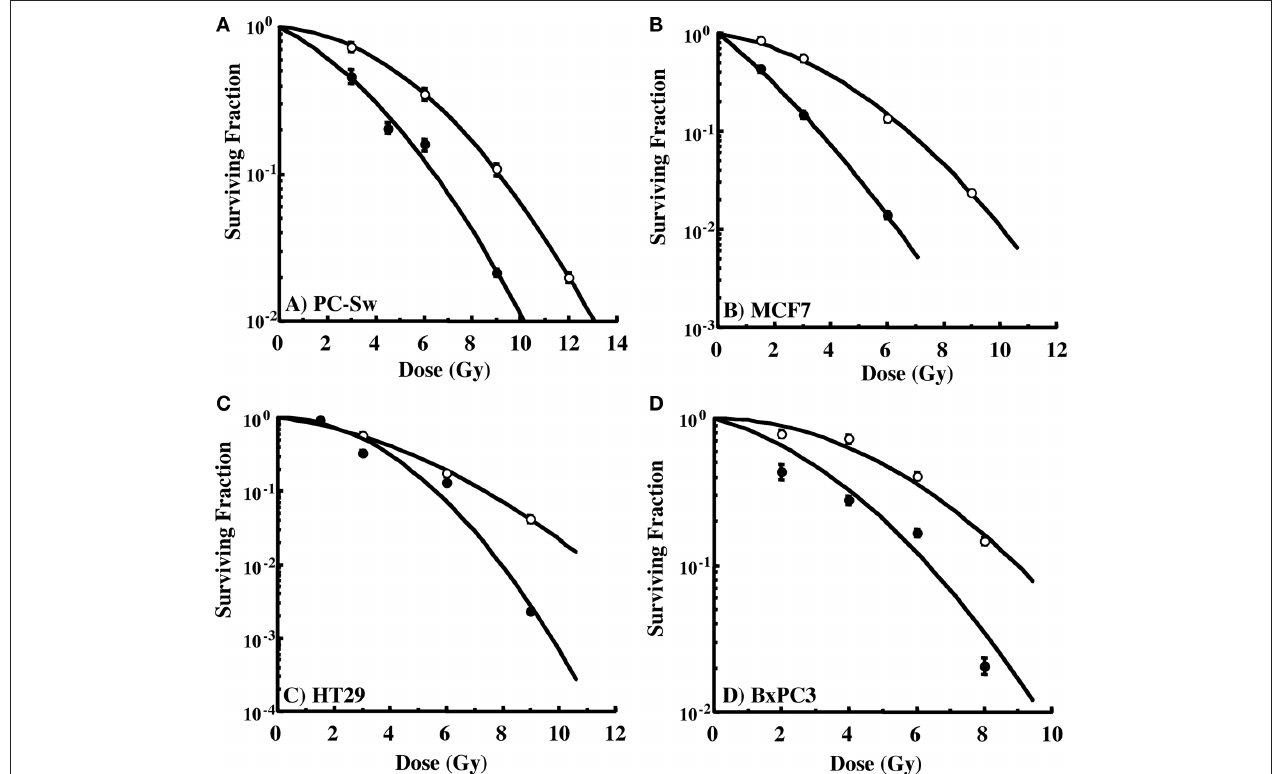
FiguRe 4 | Radiation cell survival curves for cells pre-incubated for 24 h with or without 50 or 100 μM gS and then exposed to varying doses of iR. (A) PC-Sw cells incubated with 50 μM GS for 24 h, (B) MCF7 cells incubated with 100 μM GS (C) HT29 cells incubated with 100 μM GS, (D) BX-PC3 cells incubated with 100 μM GS. GS cytotoxicity data and DMFs are shown in Table 1